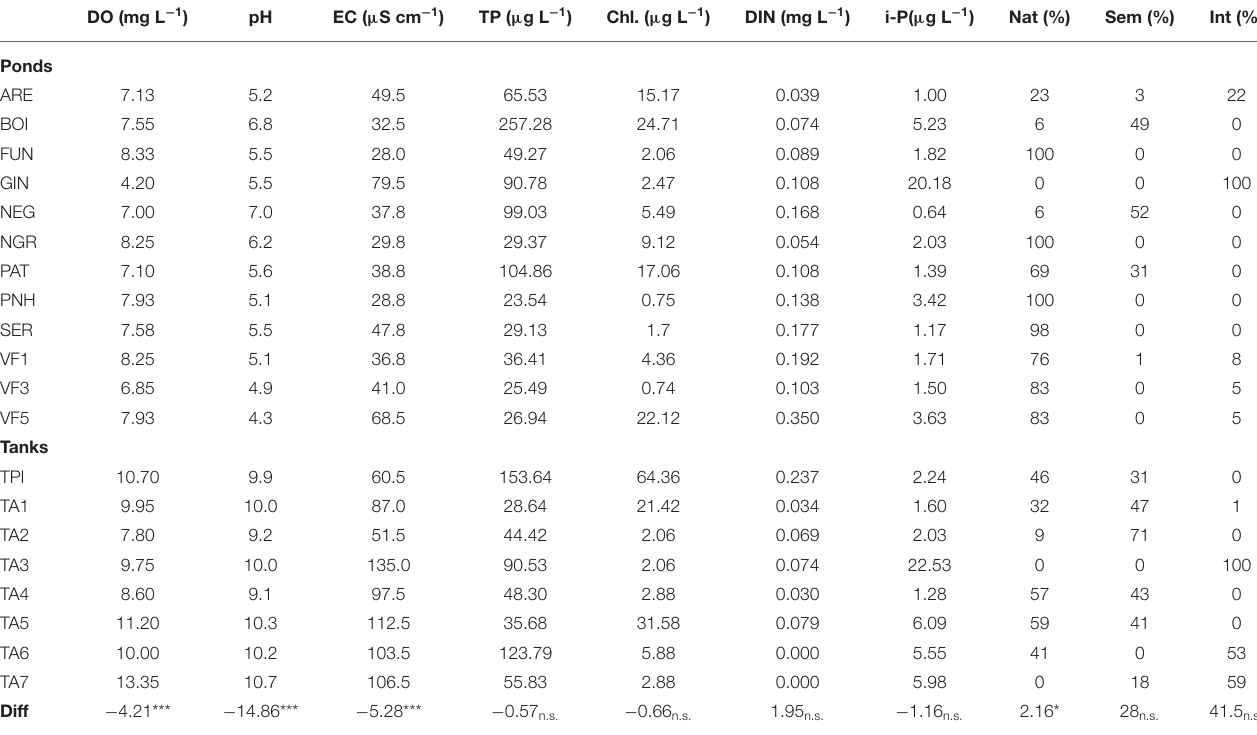
TABLE 2 | Environmental variables of the water column of the study ponds and tanks during the extensive sampling, measured in May 2014. DO (mg L − 1